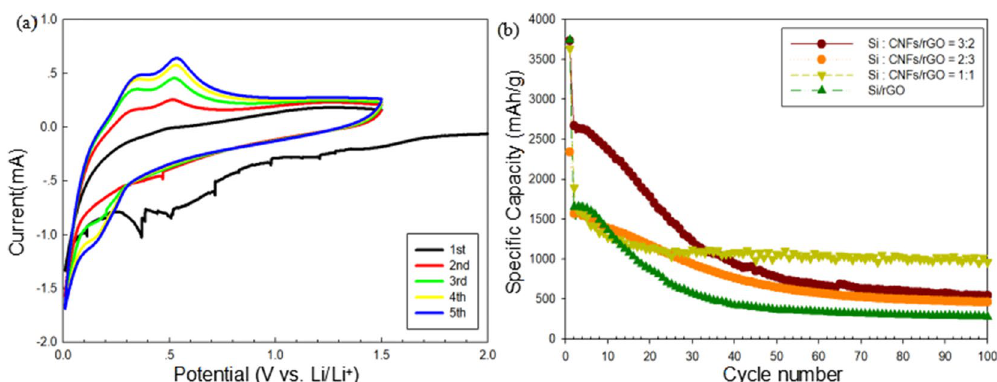
Figure 7. ( a ) Cyclic voltammetry curves of the synthesized Si/CNF/rGO = 1:1 composite in the initial five cycles. ( b ) Cycling performances of the synthesized Si/rGO and Si/CNF/rGO = 1:1, 2:3, and 3:2 composite electrodes at a current density of 0.1